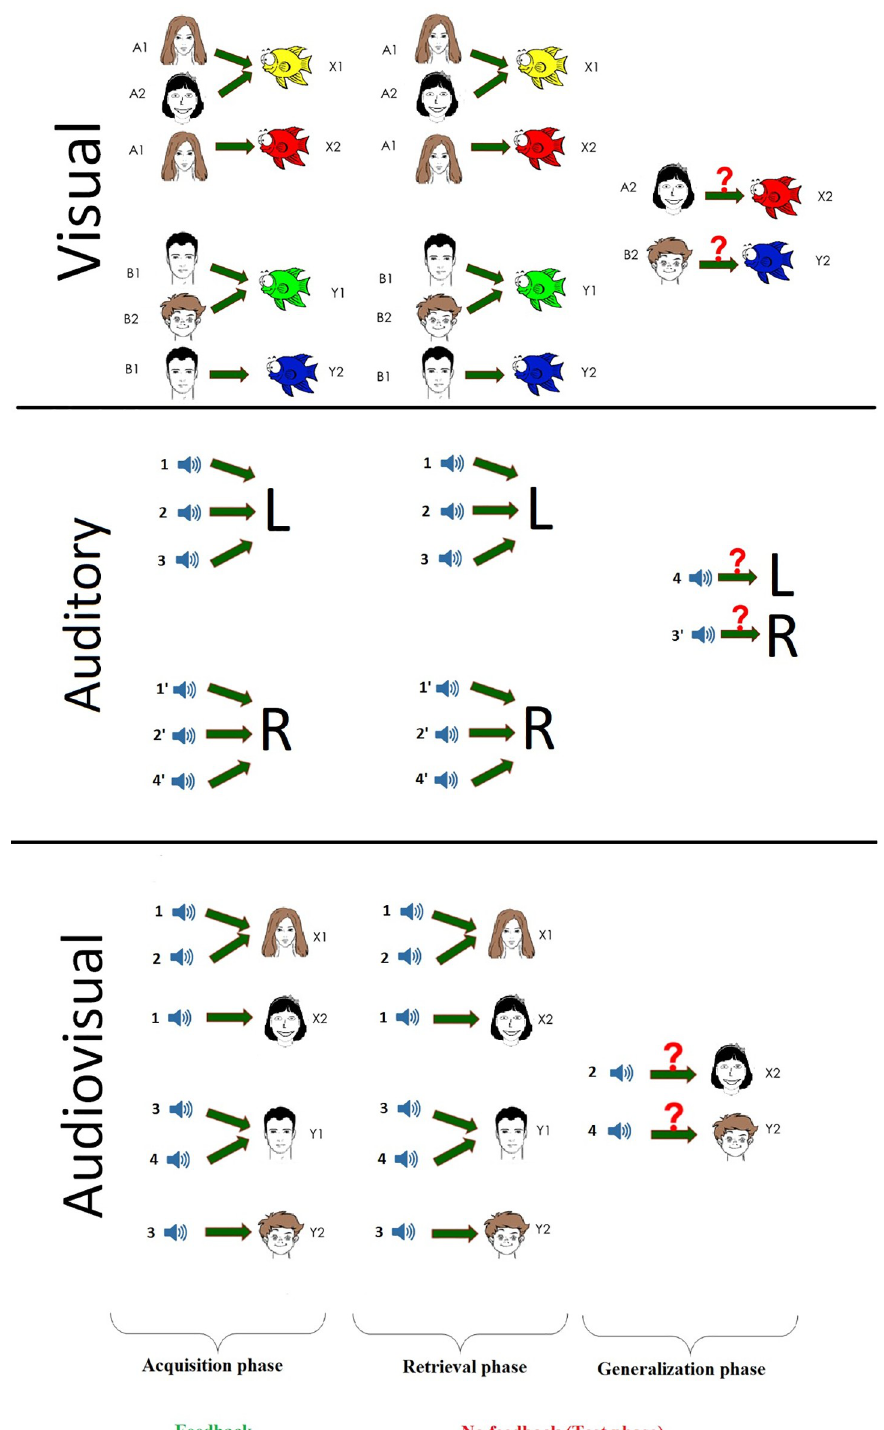
Fig 1. The schematic drawing of the applied visual, auditory and multisensory guided associative learning paradigms. See details in text.